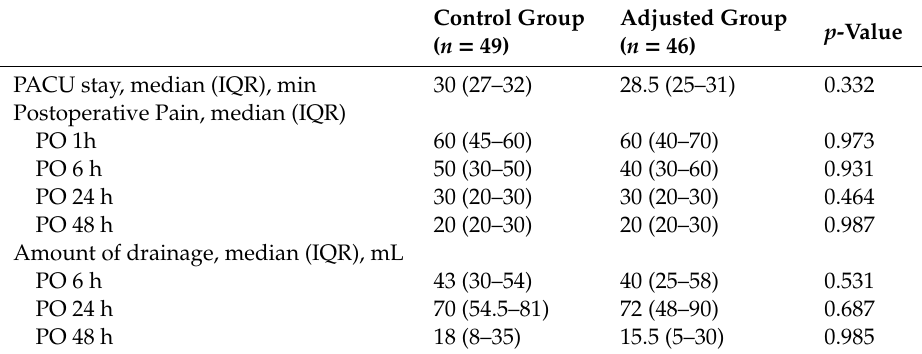
Table 2. PACU stay, postoperative pain, and amount of